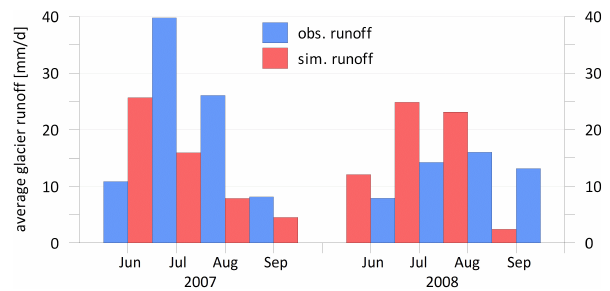
Fig. 5. Observed and simulation glacier runoff volumes.